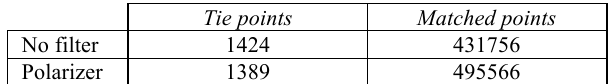
Table 4. Ceramic object #1 (Greek vase). Matching results for